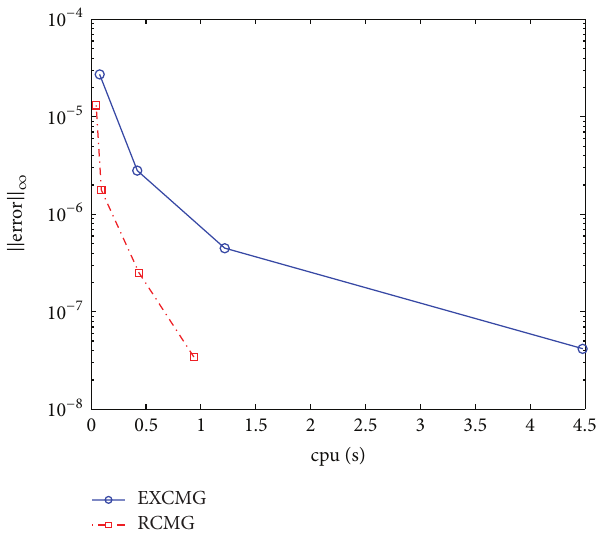
Figure 4: Comparison of the maximum error ‖𝑢 𝐿 − 𝑢‖ ∞ and cpu time for Example 5 with 𝐿 = 3 , taking step lengths ℎ 𝐿 = 1/𝑚 , 𝑚 = 64 , 128 , 256 , and 512 , respectively.